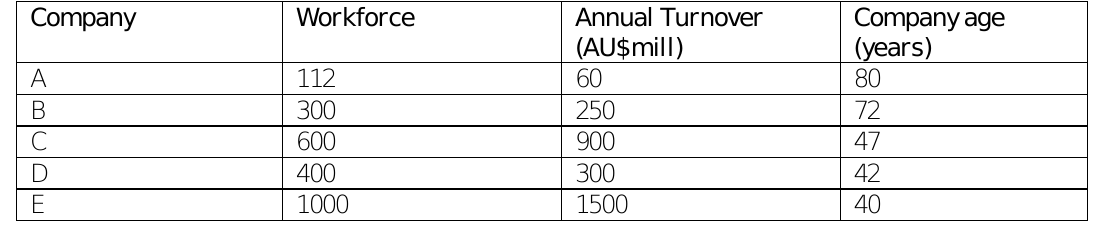
Table 2: Sample company